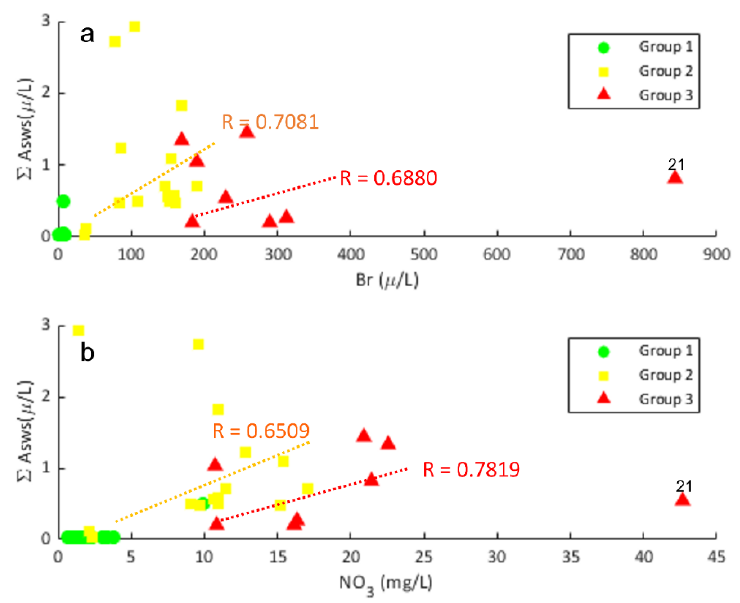
Figure 9. ( a ) Linear regression between Σ Asw3 and Br concentrations, and ( b ) between Σ Asws and NO 3 − concentrations.